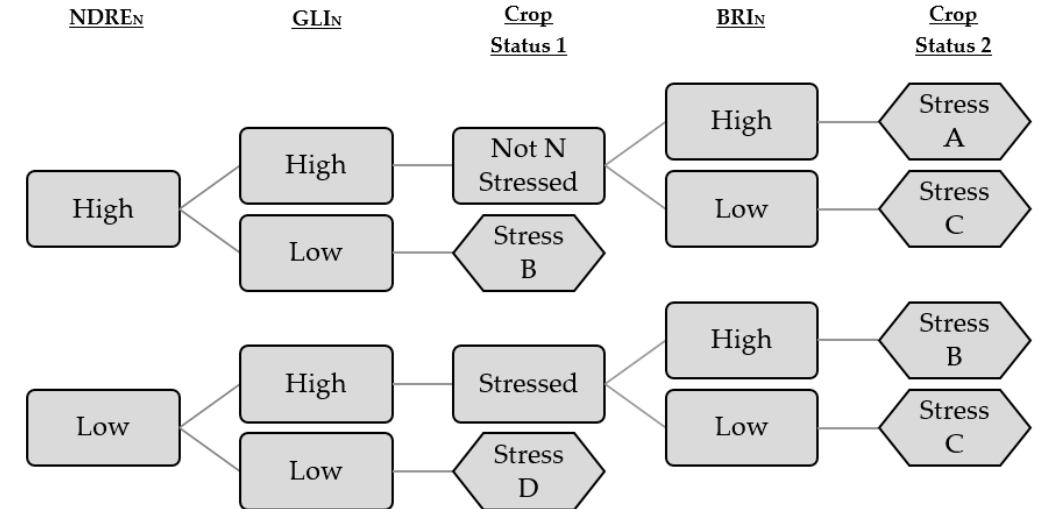
Figure 2. Combined Index (CI) used to separate experimental units into one of four nitrogen (N) or water-based crop status outcomes (Stress A, B, C, and D) based on combined normalized green leaf index (GLI N ), normalized difference red-edge (NDRE N ), and blue reflectance index (BRI N ) measurements.